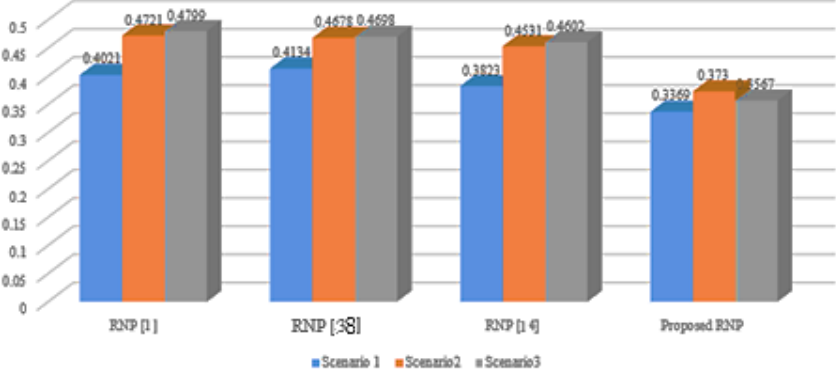
Fig. 18. Comparison of the ObjFun from different RNP models.